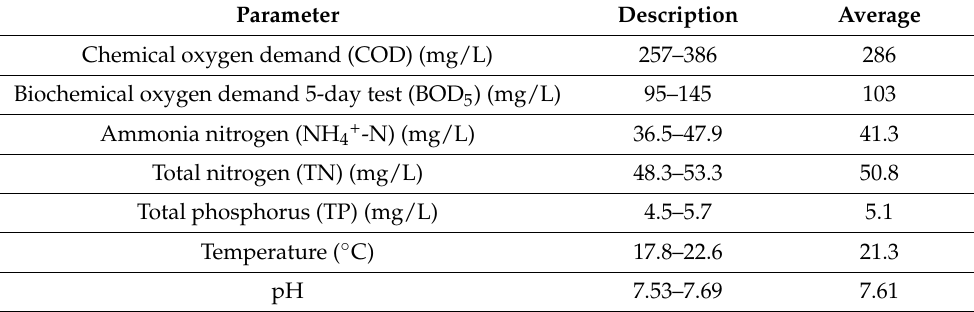
Table 1. Characteristics of the raw